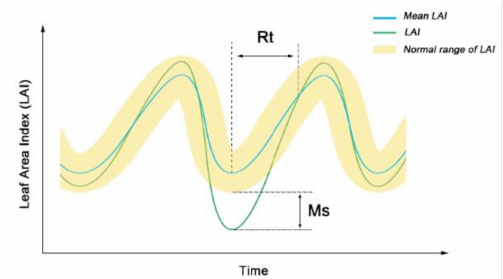
Figure 1. Simplified process of ecosystem anomaly. The two components of terrestrial resilience can be extracted: Rt is the recovery time and Ms is the maximum stress.